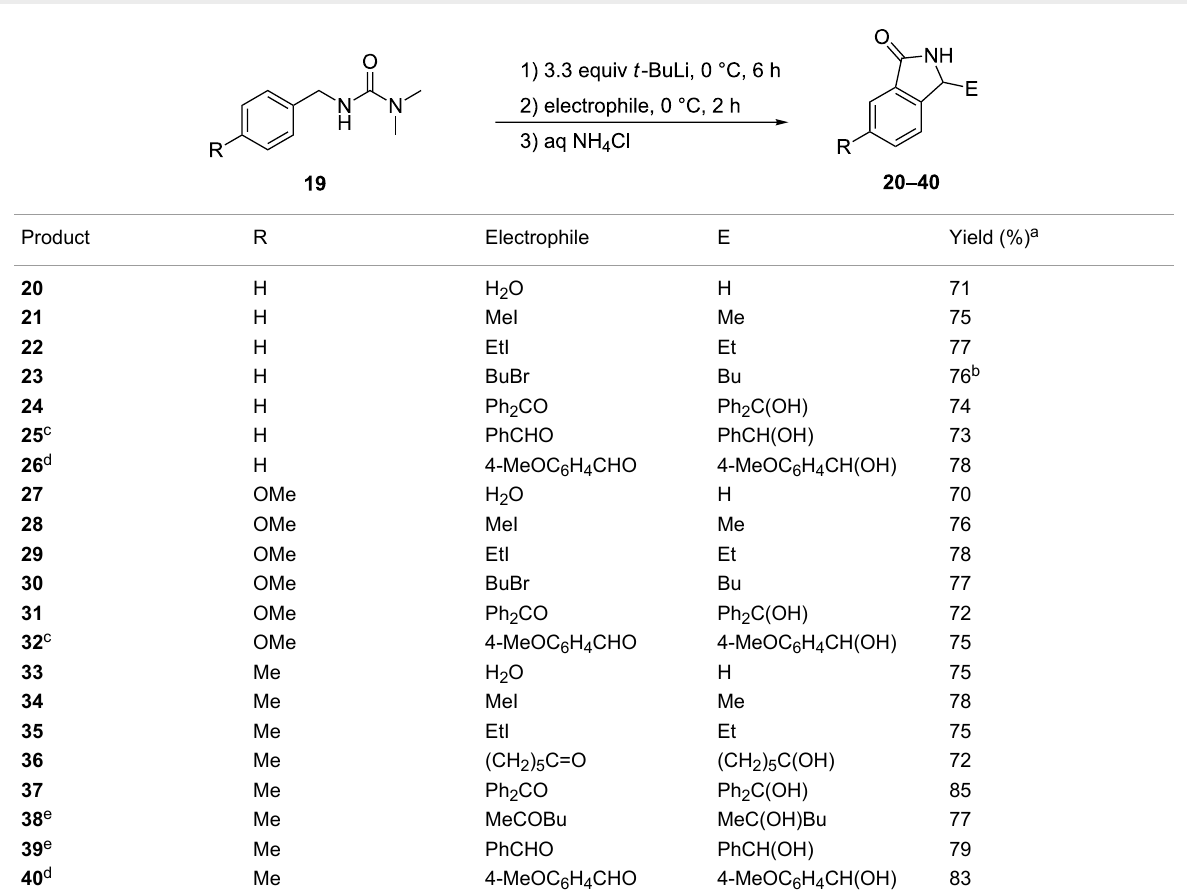
Table 2: Synthesis of various substituted isoindolin-1-ones 20 – 40